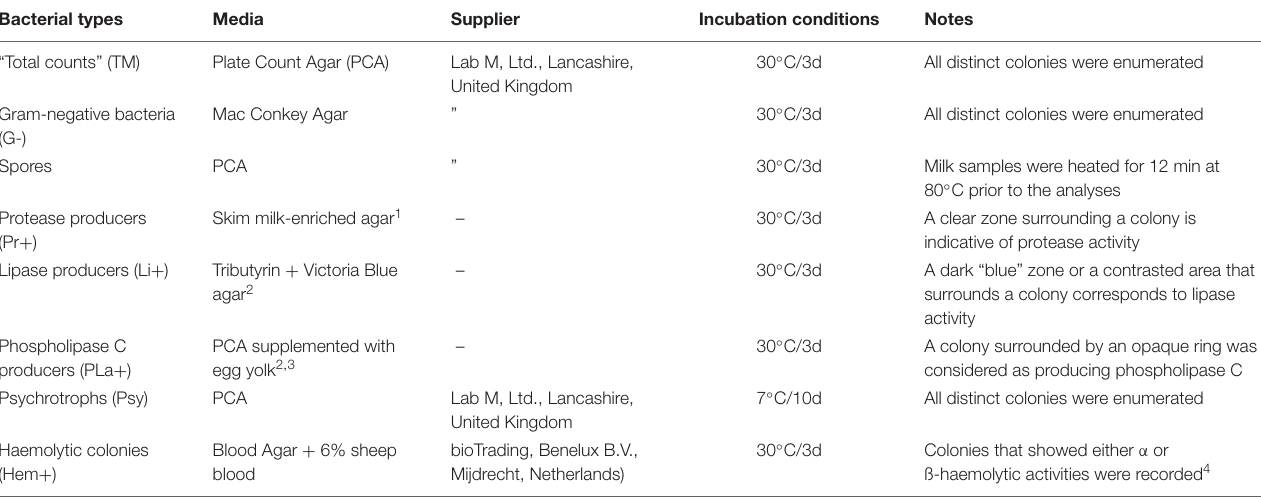
TABLE 1 | Conditions for the enumeration of the considered bacterial populations present in bovine raw milk samples (M1, M2 and M3) during cold storage for up to 7 days at 6 ◦ C. Bacterial